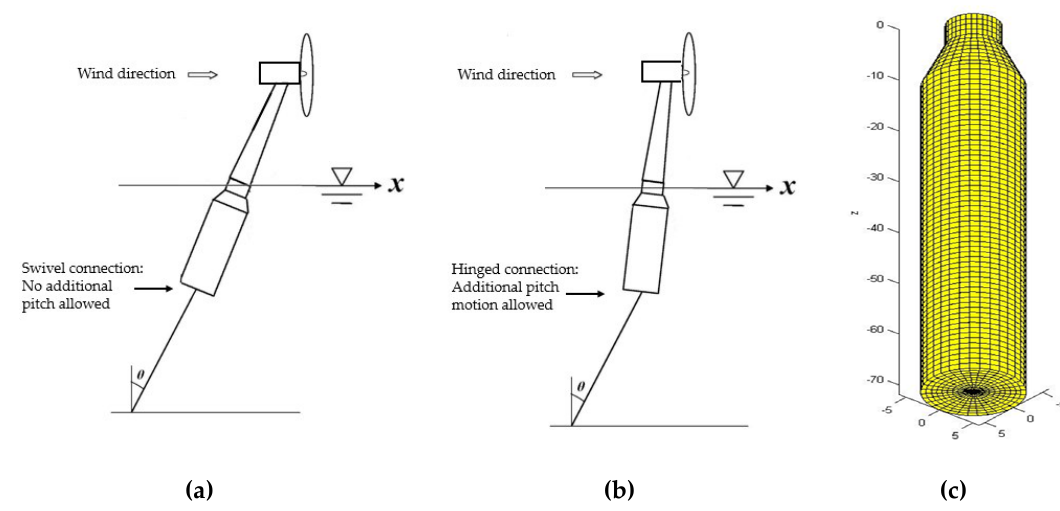
Figure 9. ( a ) Swivel connection model; ( b ) Hinged connection model; ( c ) numerical panel mesh for the support platform of FOWT. Table 10. Environmental conditions for coupled dynamics analysis.